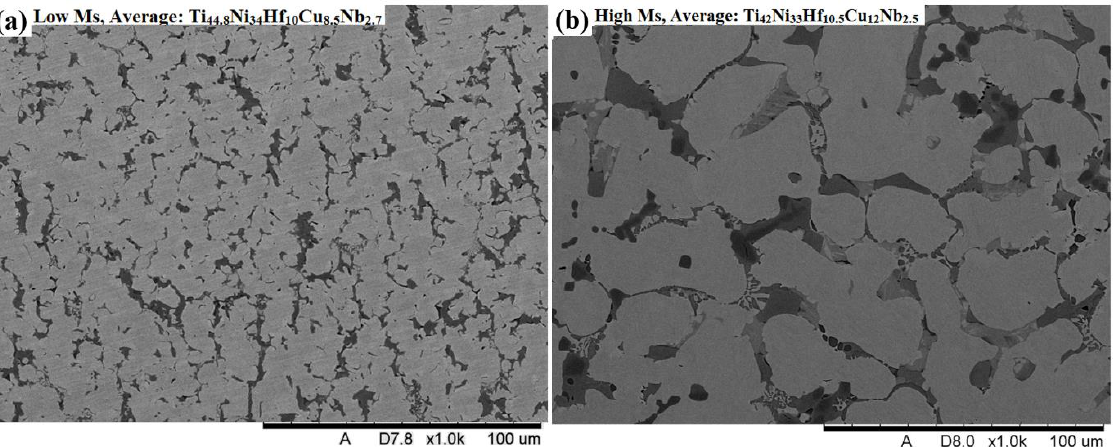
Figure 8. Backscatter image of ( a ) low M s Ti 43 Ni 33 Hf 10.5 Cu 11 Nb 2.5 sample shows fine dendrite and Ti(Hf)-rich precipitates around dendrite boundary. The EDS area analysis shows the composition of the sample is Ti 44.8 Ni 34 Hf 10 Cu 8.5 Nb 2.7 ; ( b ) high M s Ti 44 Ni 34 Hf 10 Cu 10 Nb 2 sample shows larger dendrite size and 4 different types of precipitates. The EDS area analysis result shows the sample composition is Ti 42 Ni 33 Hf 10.5 Cu 12 Nb 2.5 .